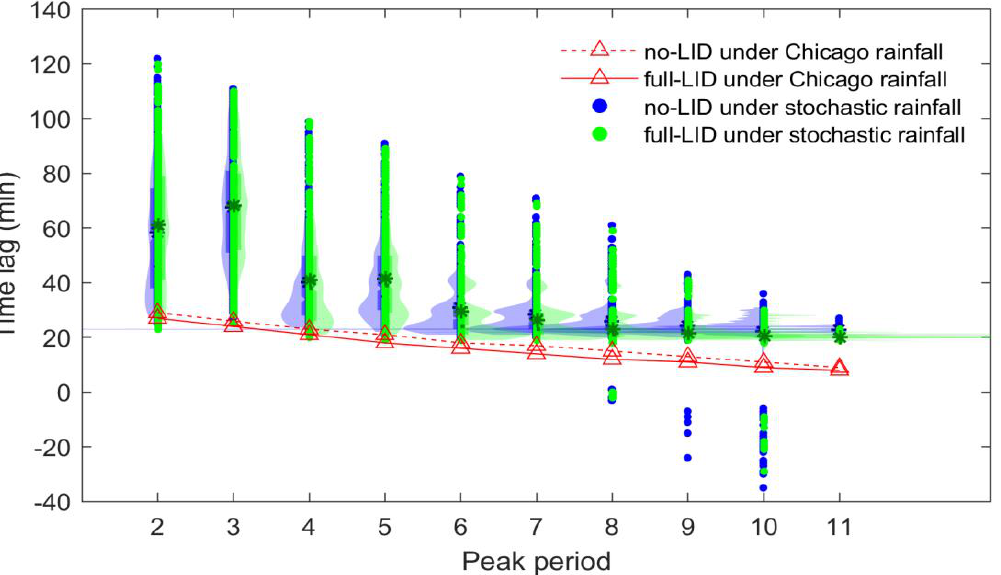
Figure 7. Time lag in no- and full-LID scenarios under Chicago and stochastic precipitation events. * represents the median.